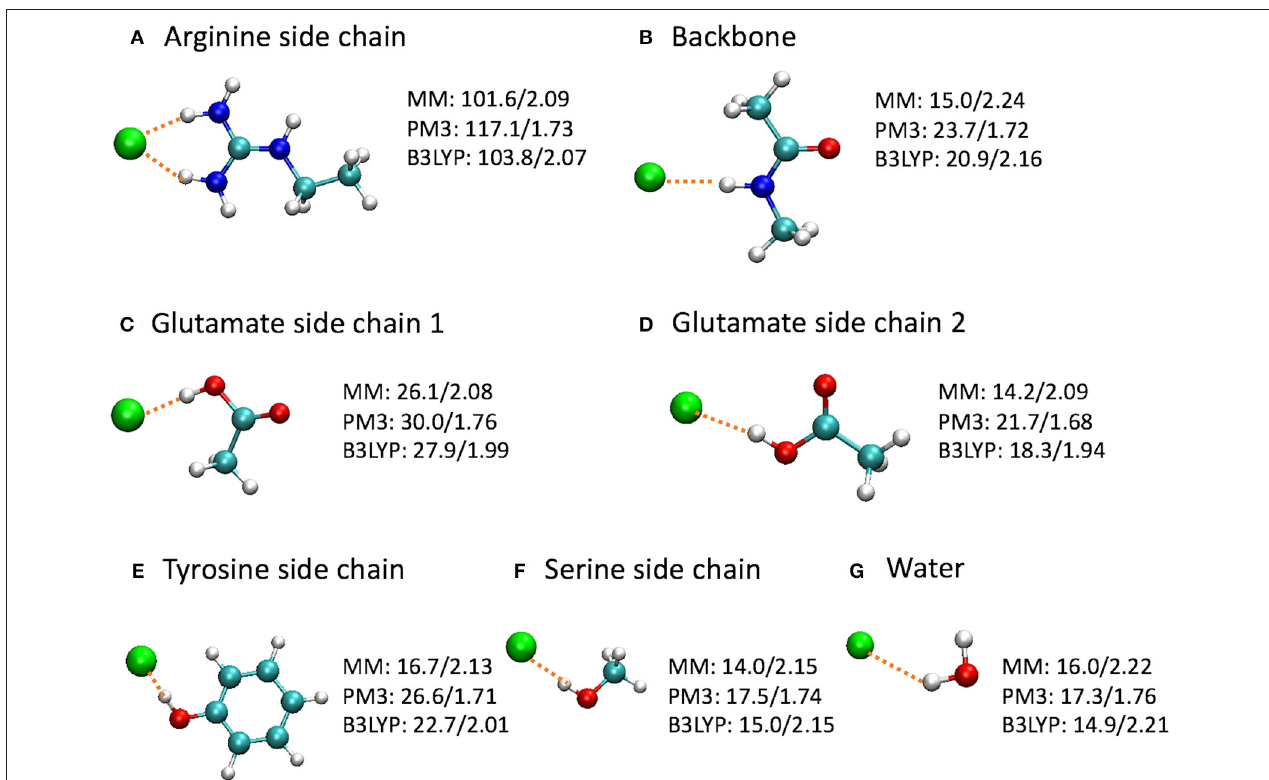
FIGURE 9 | Optimized model complexes formed between Cl − and (A,C-F) side chain, (B) backbone, and (G) water models, where the binding energies (kcal/mol)/H–Cl distances (Å) are listed next to each complex. The binding energy is defined as E (bind) = E (Cl − ) + E (model) – E (complex), where the energies are at the optimized geometries at the given level of theory. The average H–Cl distance was shown for the arginine side chain model. The MM calculations employed the CHARMM36 force field and TIP3P water